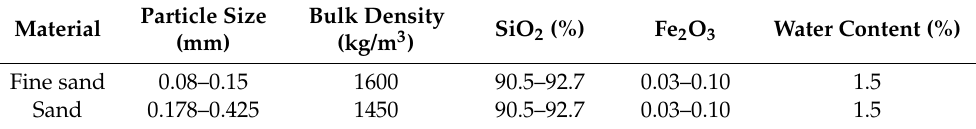
Table 5. Properties of fine sand and